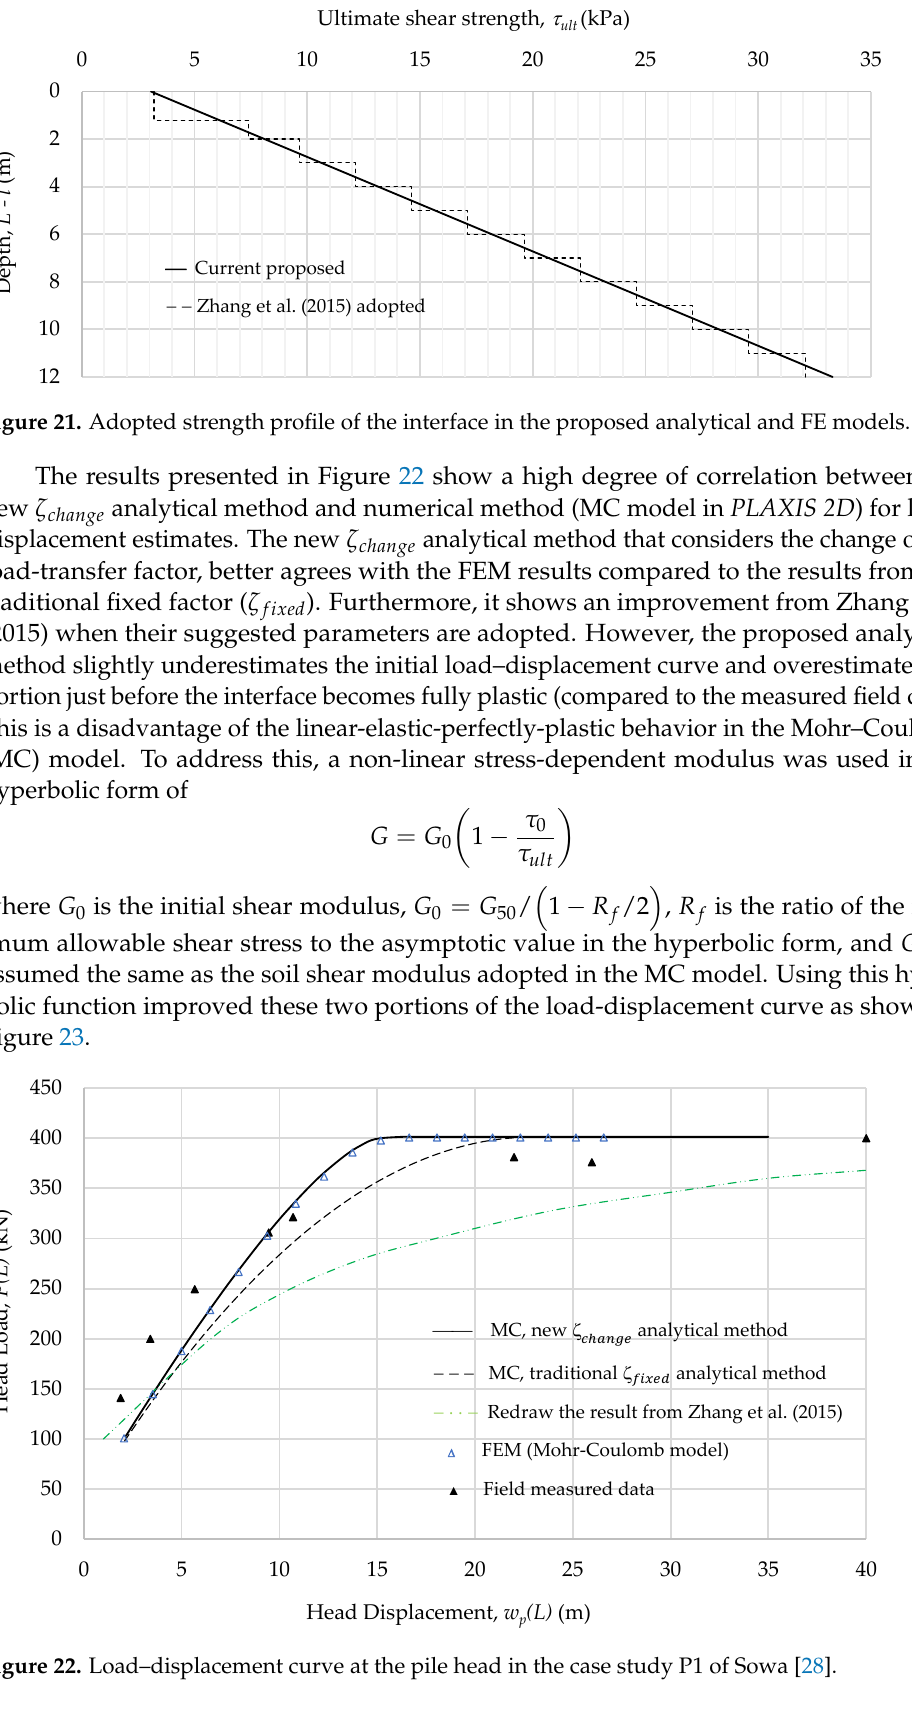
Figure 23. Further improvement by using a nonlinear hyperbolic analytical model. 5. Conclusions Many researchers have considered the pile–soil slipping theory in the analytical method by introducing an interface in the analytical formulation that allows relative displacement between the pile and soil surfaces. It is similar to many rigorous numerical methods that adopt interface elements to simulate the pile–soil slipping behaviors to achieve more accurate and realistic results. This study investigated the use of the existing load-transfer factor (a constant value during pile loading and devised under the elastic soils) in slipping analytical models and found deviation in the load–displacement results as explained by mathematical theories and numerical results. It draws attention to the use of the existing load-transfer factor in the slipping analytical theory. The study shows a constant  factor is valid in elastic soils and soils with a constant ratio of shear modulus to strength in the Gibson condition for axially loaded piles. Some cohesionless soils are